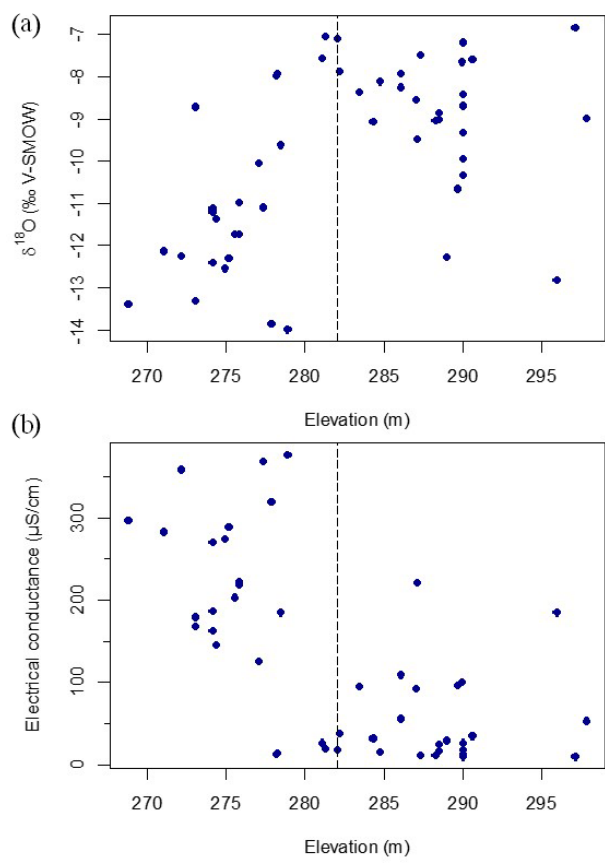
Figure 3. Relation between δ 18 O in water samples and elevation ( r = 0 . 53, n = 50 and p < 0 . 001) (a) and between specific conduc- tance and elevation ( r = − 0 . 67, n = 50 and p < 0 . 001) (b) . The horizontal dashed line indicates the position of a breakpoint anal- ysis, which occurs at an elevation of ∼ 282ma.s.l. in both cases (Table 1).